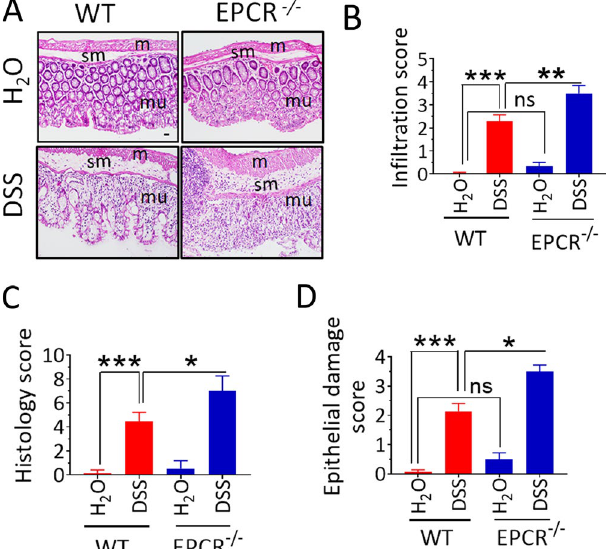
Figure 3. Histopathology of DSS-induced colitis in wild-type and EPCR −/− mice. The colon tissues collected from the control and DSS-treated (2.5% w/v in the drinking water for 10 days) mice were processed for tissue sectioning and staining with H&E stain. Epithelial damage, infiltration, and histology were scored as described in Methods. ( A ) Representative images of H&E stained colon tissue sections. Sections were imaged at 10X magnification. The scale bar, 80 µm. m, muscularis externa; sm, submucosa; mu, mucosa. ( B ) Infiltration score; ( C ) Histology score; and ( D ) Epithelial damage score. Data are the mean ± SEM of 2 independent experiments of 8 mice/group. * P < 0.05; ** P < 0 .01; *** P < 0.001; ns, no statistically significant